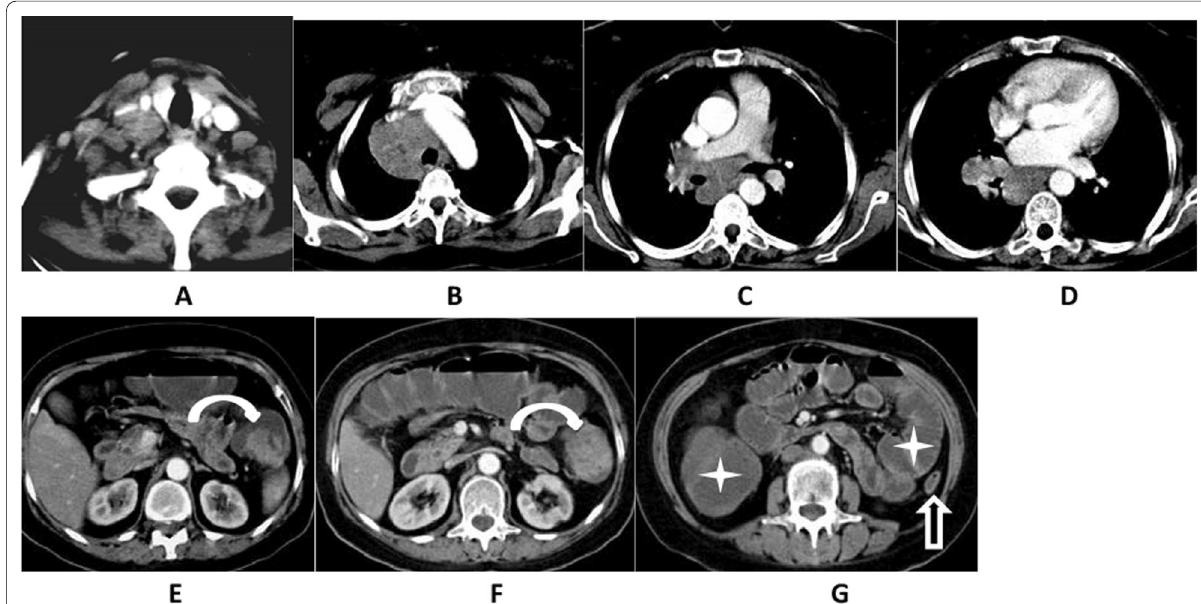
Fig. 3 60‑year‑old female presented with colonic obstruction. CT scan neck and chest revealed right lower cervical, mediastinal, right hilar and sub‑carinal malignant lymphadenopathy ( A – D ). Biopsy revealed HD. CT scan abdomen ( E , F ) revealed splenic flexure cauliflower mass proved to be colonic carcinoma (curved arrows) ( E , F ). CT scan ( G ) revealed proximal intestinal obstruction (asterisks) with collapsed descending colon (arrow)